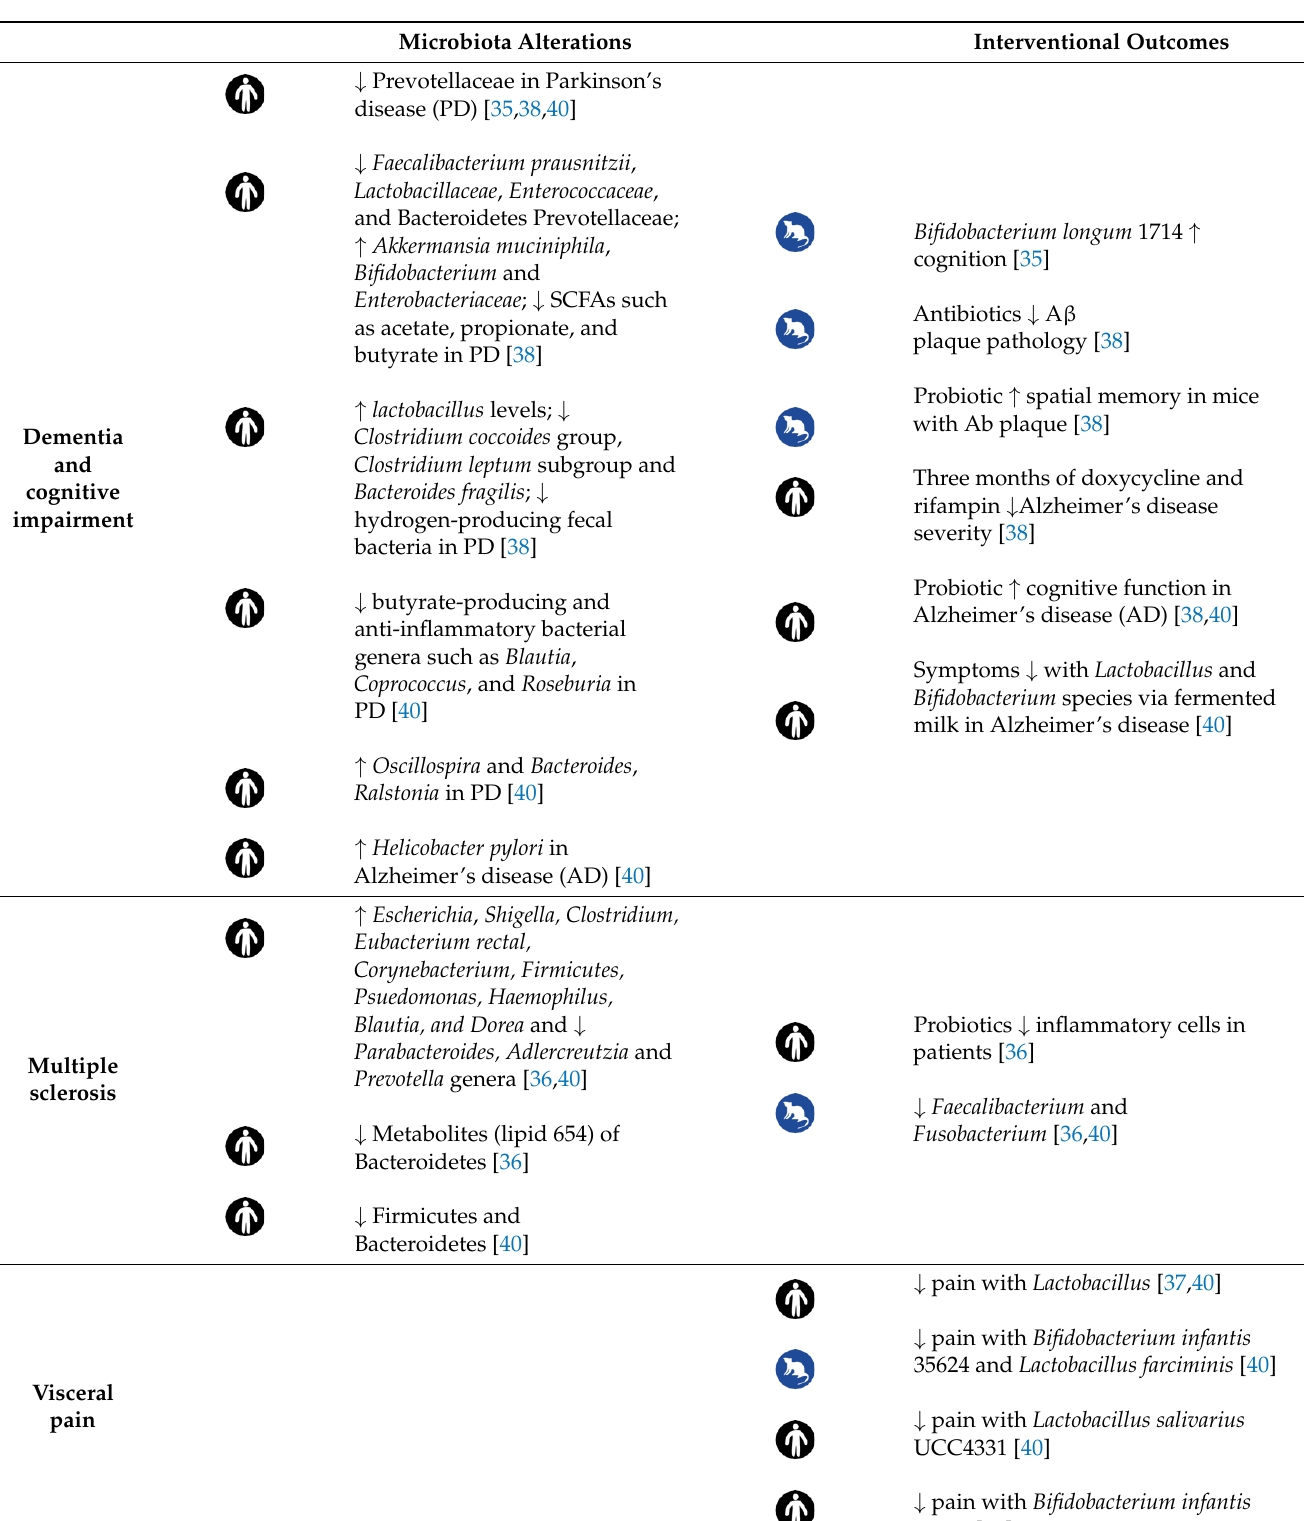
Table 1. Microbiota -based interventions and their effect on the various neuropsychiatric disorders.